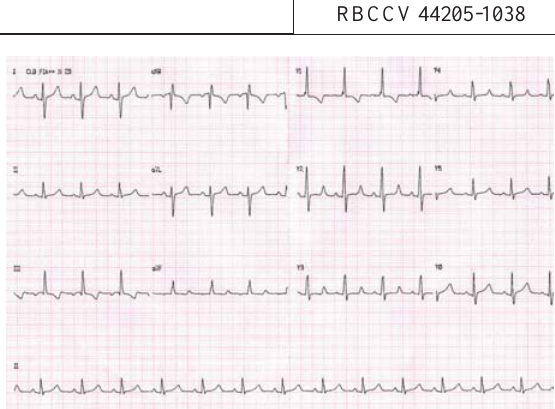
Fig. 1 – Eletrocardiograma chamando pouca atenção para comunicação interatrial